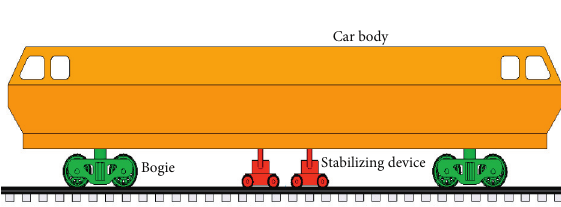
Figure 1: Structure diagram of the WD-320 dynamic track stabilizer.